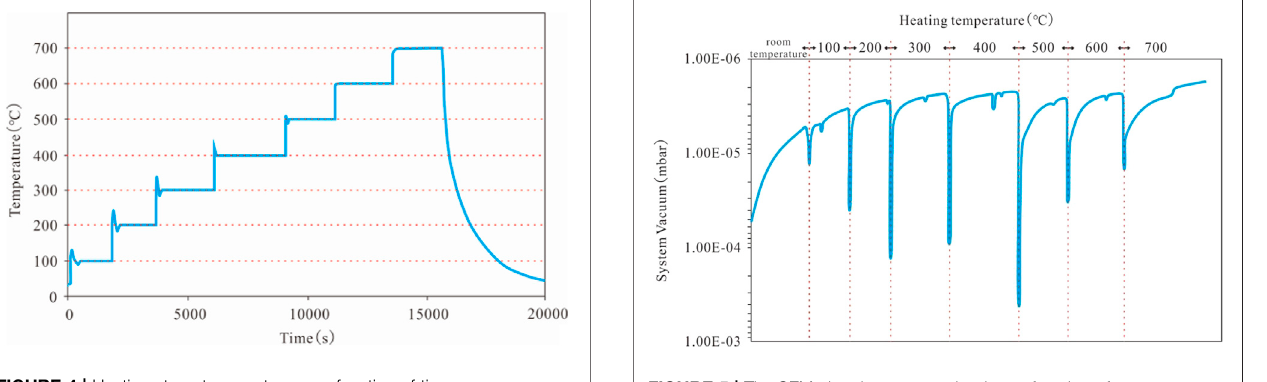
FIGURE 4 | Heating stage temperature as a function of time. FIGURE 5 | The SEM chamber vacuum level as a function of